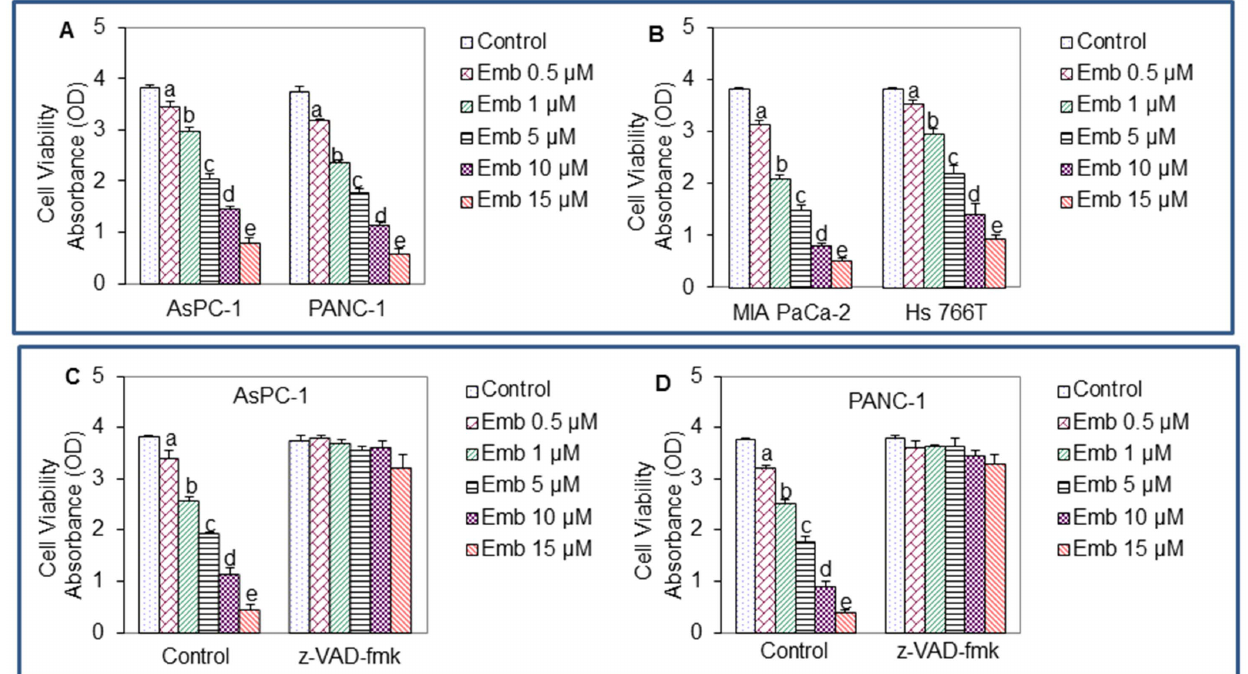
Figure 1. Embelin inhibits cell viability in pancreatic cancer cell lines. (A and B), Pancreatic cancer AsPC-1, PANC-1, MIA PaCa-2 and Hs 766T cell lines were treated with embelin (0–15 m M) for 48 h. At the end of incubation period, XTT assays were performed to measure cell viability. (C and D), Effects of pan caspase inhibitor on anti-proliferative effects of embelin. Pancreatic cancer AsPC-1 and PANC-1 cells were pre-incubated z-VAD-fmk (10 m M) for 2 h and treated with various doses of embelin (0–15 m M) for 48 h. Cell viability was measured by XTT assay. Data represent the mean 6 S.D. a, b, c, d, and e=significantly different from respective control, P , 0.05.